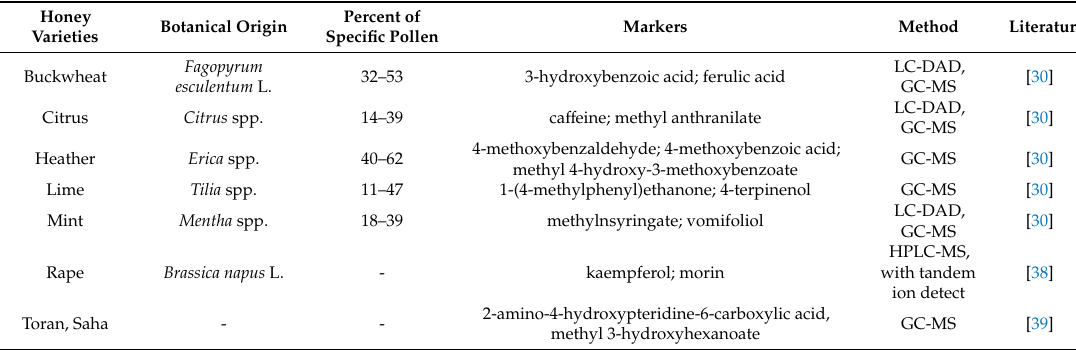
Table 3. Markers for selected varieties of